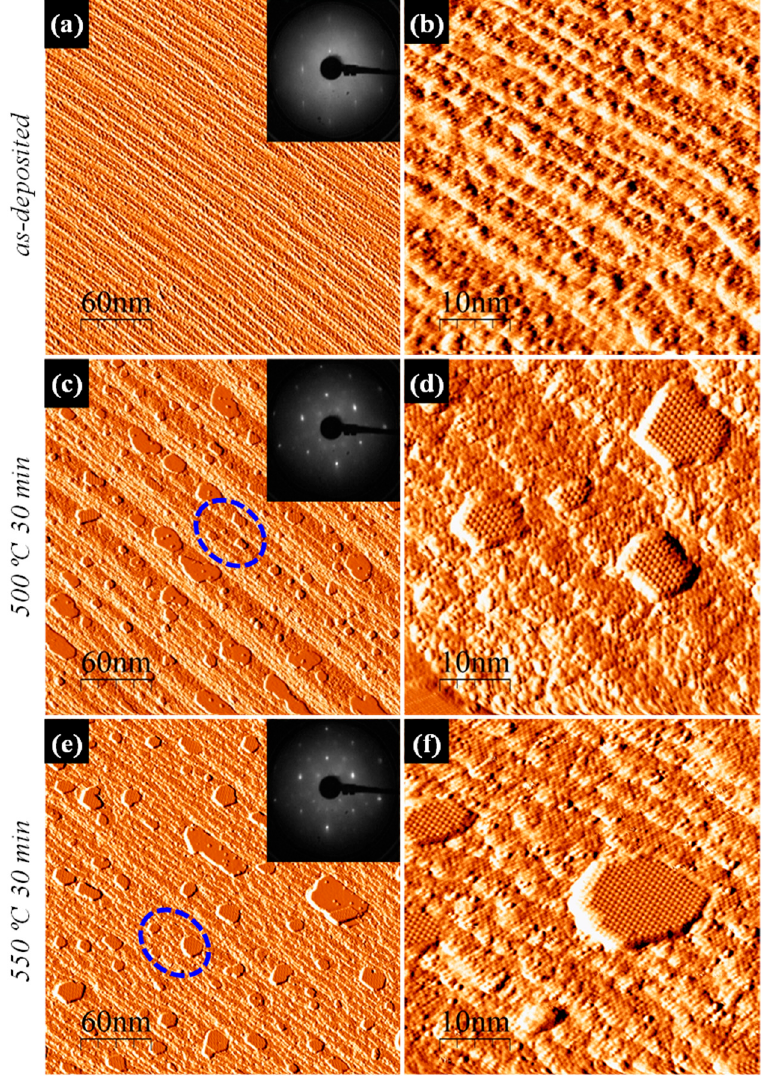
Figure 1. ( a , c , e ) Low and ( b , d , f ) high magnification STM topographic derivative images with corresponding LEED patterns in the insets, of various stages of Py SPE growth and anneals on 5°-miscut vicinal Si(111) substrate: ( a , b ) as-deposited, and ( c , d ) subsequently annealed at 500 °C for 30 min and ( e , f ) 550 °C for 30 min. Regions encircled in ( c , e ) are the ones blown-up in ( d , f ), respectively.